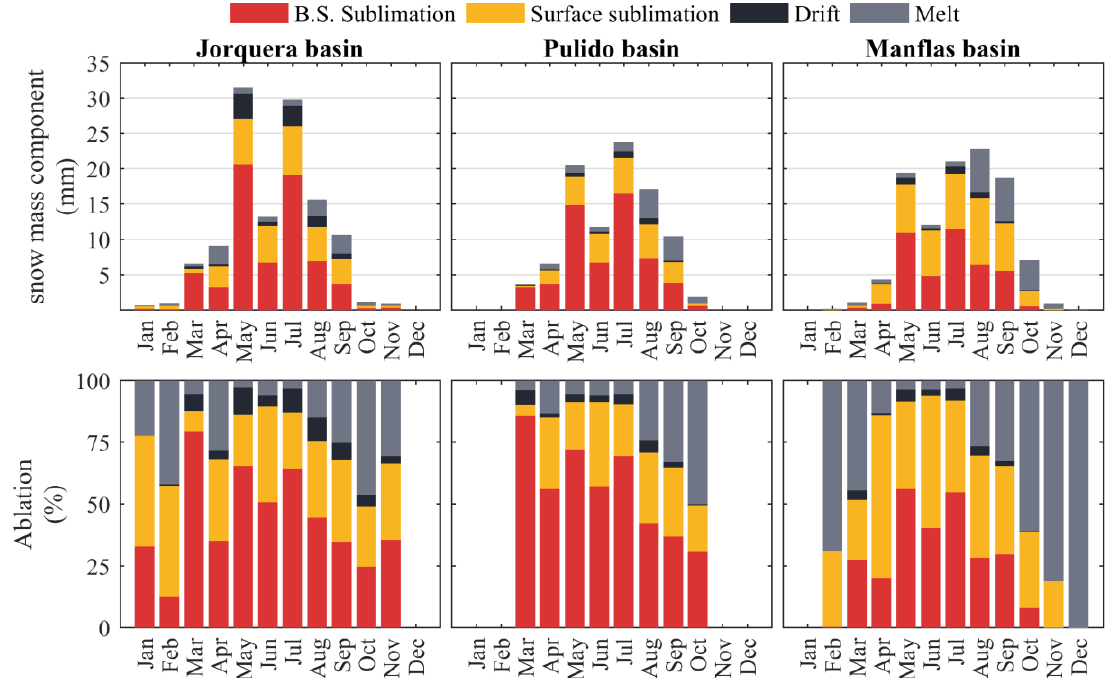
Figure 7. Monthly average snow water balance components at the Upper Copiapó basin between 2001 and 2015. Average monthly snow mass components ( top ) and percent of the ablation ( bottom ). B.S: blowing snow.